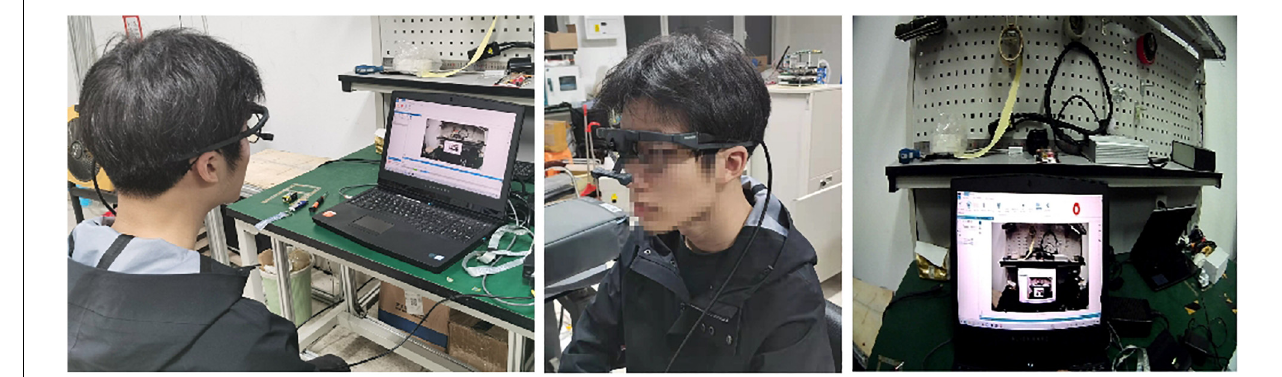
FIGURE 4 | Collection of the subject’s eye movement data.